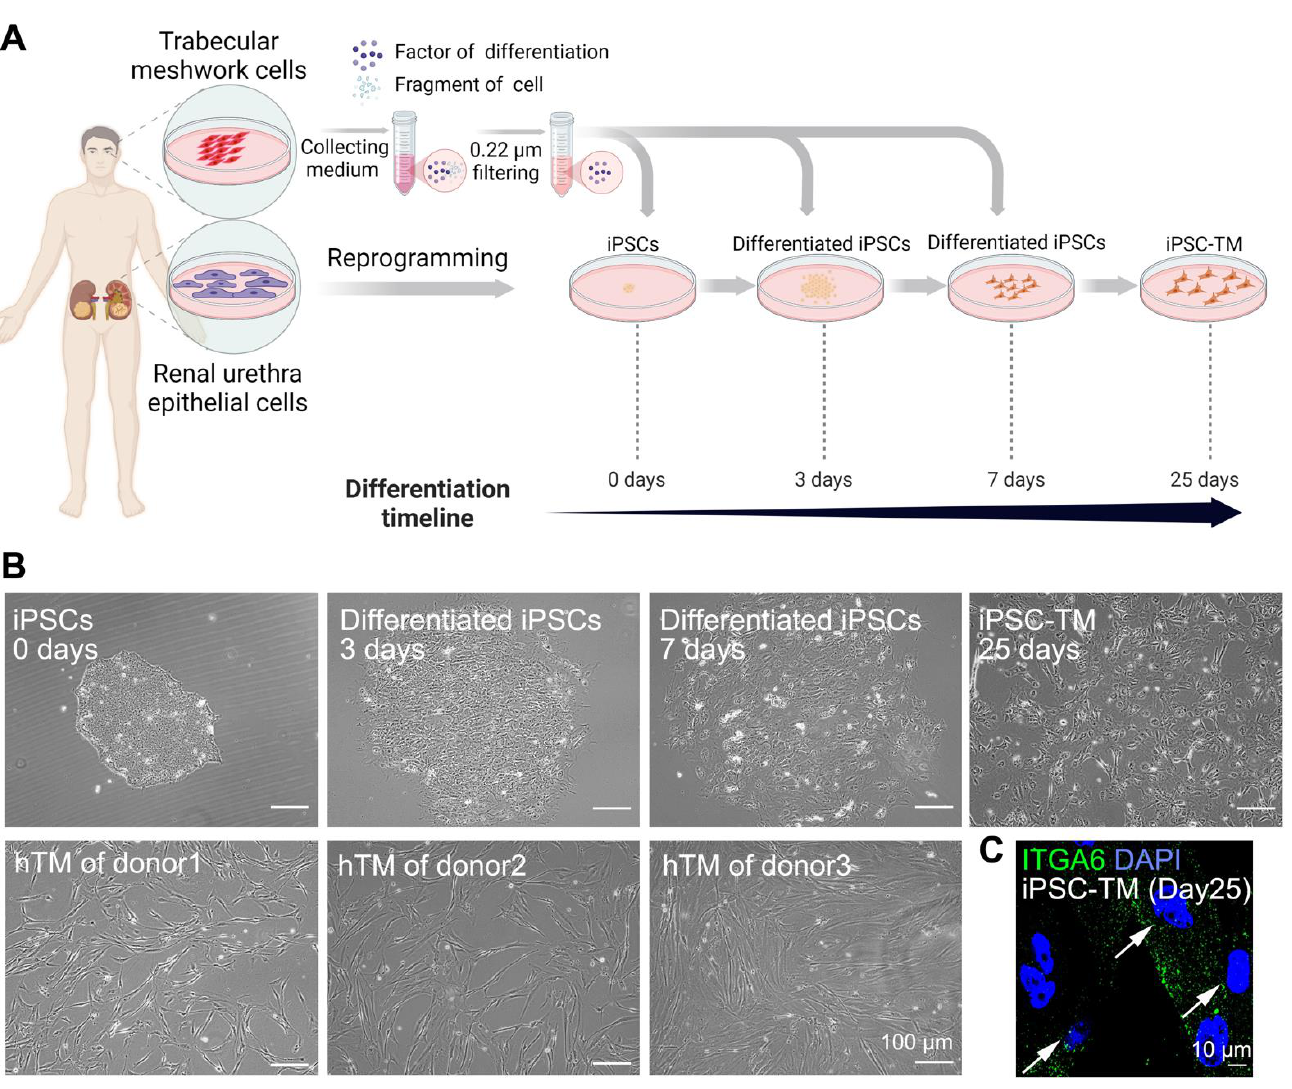
Figure 1. Differentiation of iPSCs into TM-resembling cells by the conditioned medium. ( A ) Schematic illustration of iPSC generation and differentiation by the conditioned medium approach. ( B ) Representative morphology of iPSCs, differentiated iPSCs for 3, 7, and 25 days, and hTM cells of three donors. Scale bars, 100 µm. ( C ) IHC staining of ITGA6 (green) and nuclei (blue) shows only partial iPSC-TM expressing ITGA6 (pointed by the arrows). Scale bars, 10 µm.